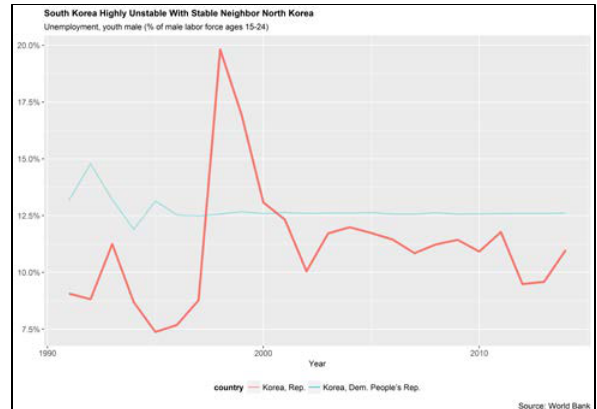
Figure 7. South Korea Identified with the Highest over time than its neighbours is Ghana. The trend of Ghana and its neighbours are shown in Figure